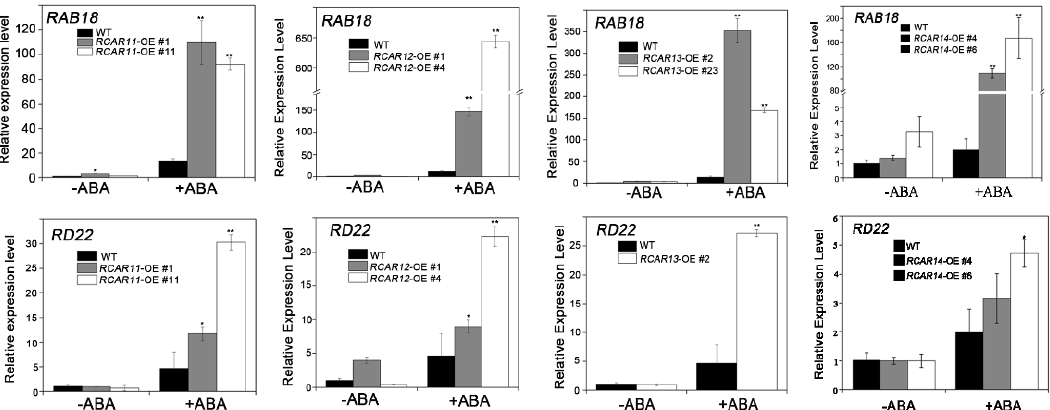
Figure 6. The RCAR11/12/1/14 attenuates the expression of several ABA-responsive genes. The relative expression levels of the ABA-responsive genes RAB18 and the drought-responsive genes in the wild-type and RCAR11/12/13 overexpression transgenic plants. The relative expression levels of RAB18 and RD22 in the WT and RCAR11/12/13/14 -OE transgenic plant lines. Two-week-old seedlings were incubated in MS liquid medium with or without 50 µ M ABA for 3 h. The transcriptional levels were determined by qRT-PCR analysis. Values are means ± SD ( n = 3). ACTIN2/8 was used as an internal control. The experiments were repeated three times with similar results (* p < 0.05, ** p < 0.01, Student’s t